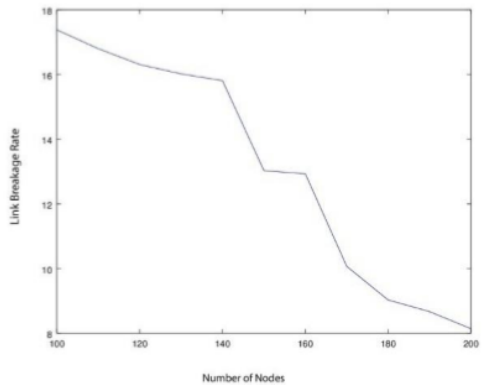
Figure 4 reveals the GPCR’s link disconnection rate w.r.t. number of nodes. Greater the number of nodes, lesser is the possibility of link